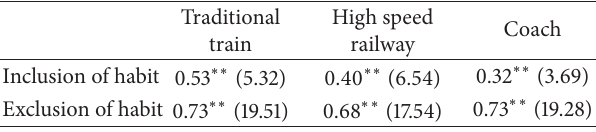
Table 6: Habit as moderate between intention and behavior. Traditional High speed Coach train railway Inclusion of habit 0.53 ∗∗ (5.32) 0.40 ∗∗